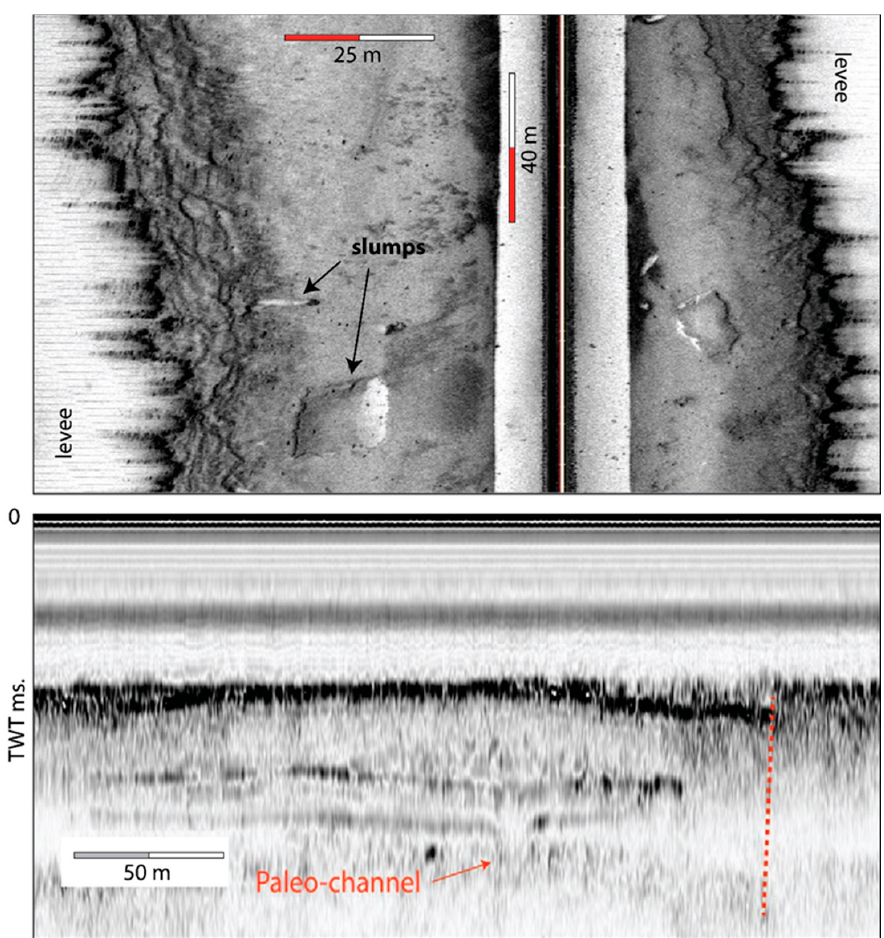
Figure 10. Top: side-scan sonar image of the Cavo Napoleonico artificial channel close to the epicenter of the Emilia 2012 earthquake, showing slumps and gravitative failures affecting the channel-floor. Bottom: SBP profile collected in the same area, penetrating the first meters of alluvial sediments, showing paleo-channels and displacements reaching up to the surface.